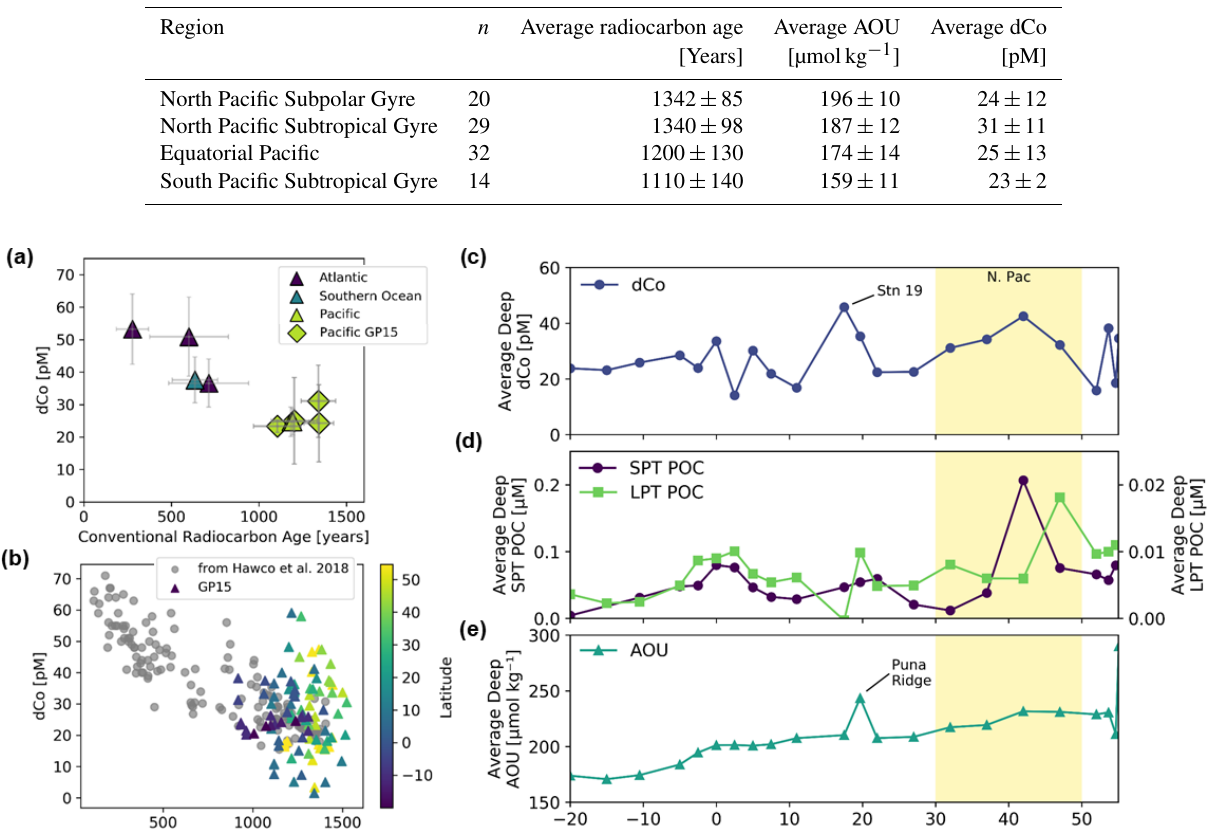
Table 5. Average conventional radiocarbon age, apparent oxygen utilization (AOU) and dCo of the deep Pacific Ocean ( > 3000m depth). GP15 samples were matched with their nearest (cid:49) 14 C and AOU observations from the GLODAP database.